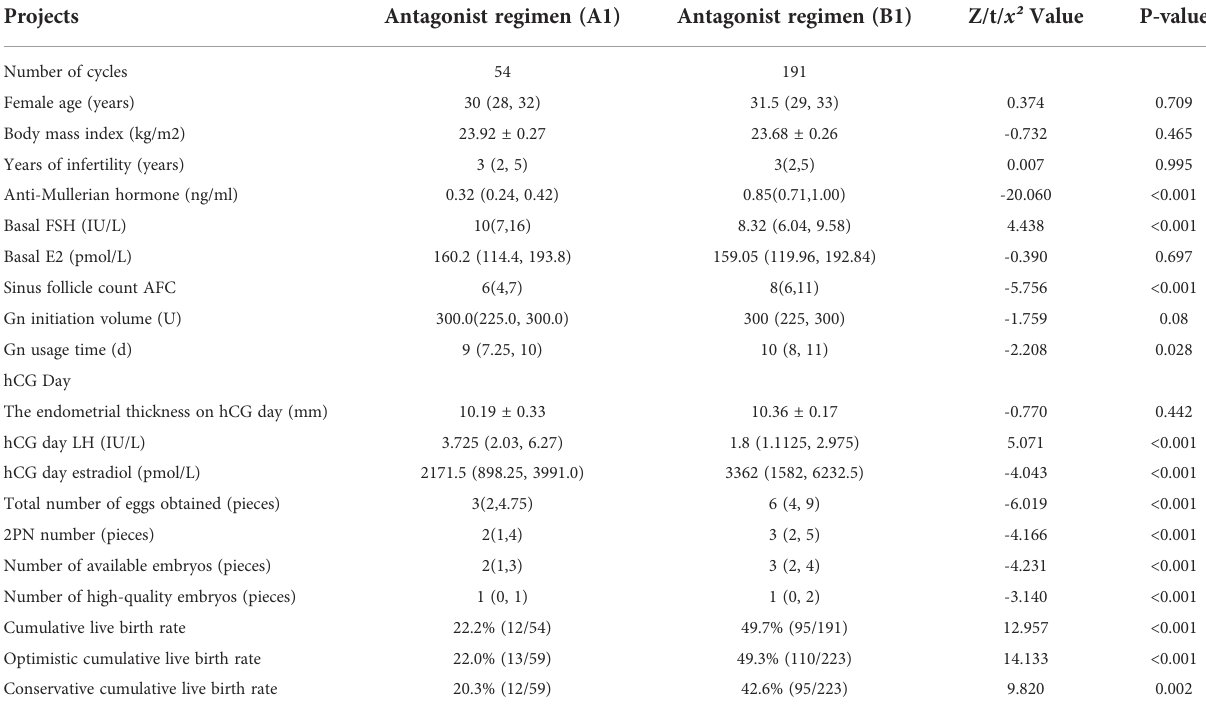
TABLE 1 Comparison of basic clinical information and laboratory results of patients with different AMH levels using antagonist regimens.